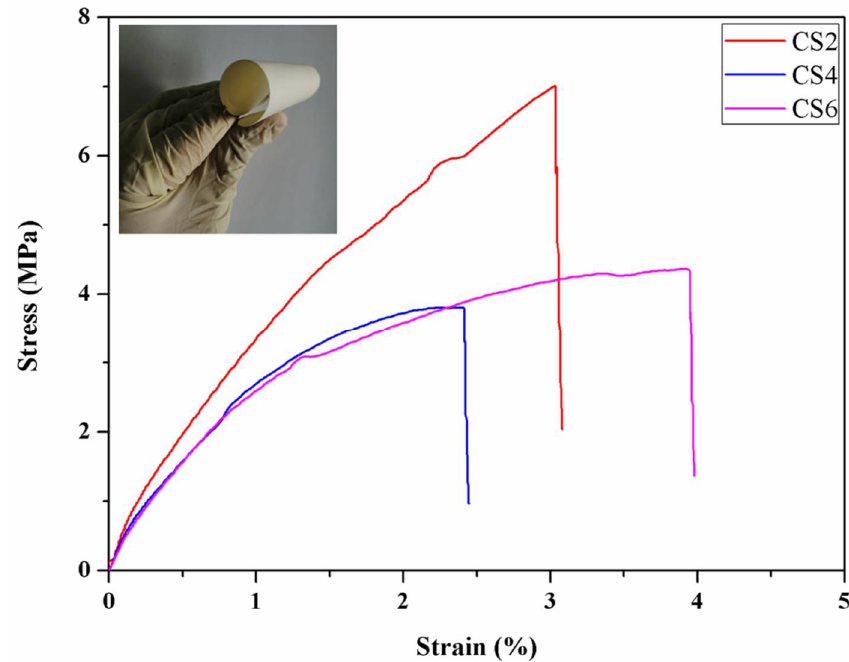
Figure 5. Strain-stress curves of the composite membranes.